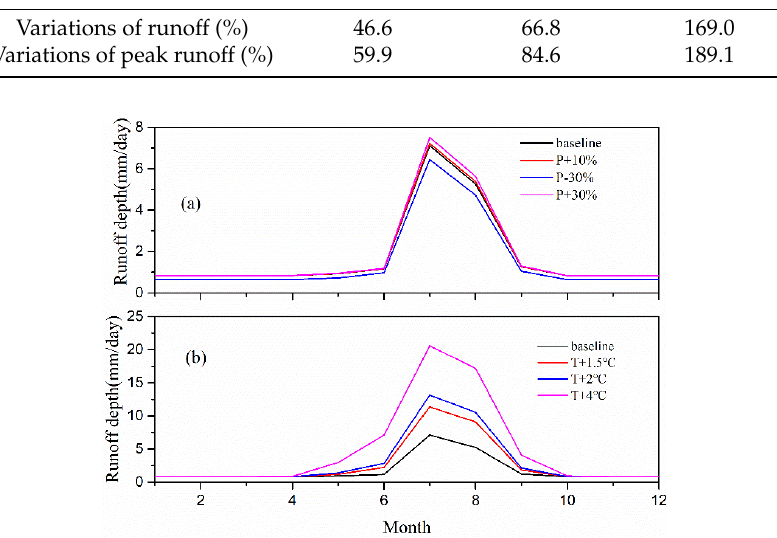
Figure 12. Compared with baseline, sensitivity analysis of runoff depth under different precipitation ( a ) and temperature ( b ) change scenarios (1959–1961).